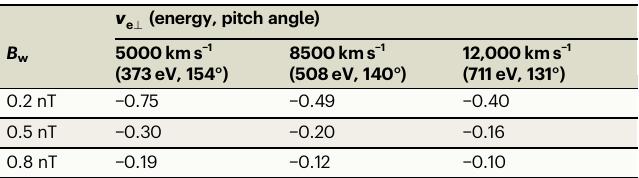
Table 1 | Inhomogeneity factor ( S ) for nonlinear wave growth at V res (Event